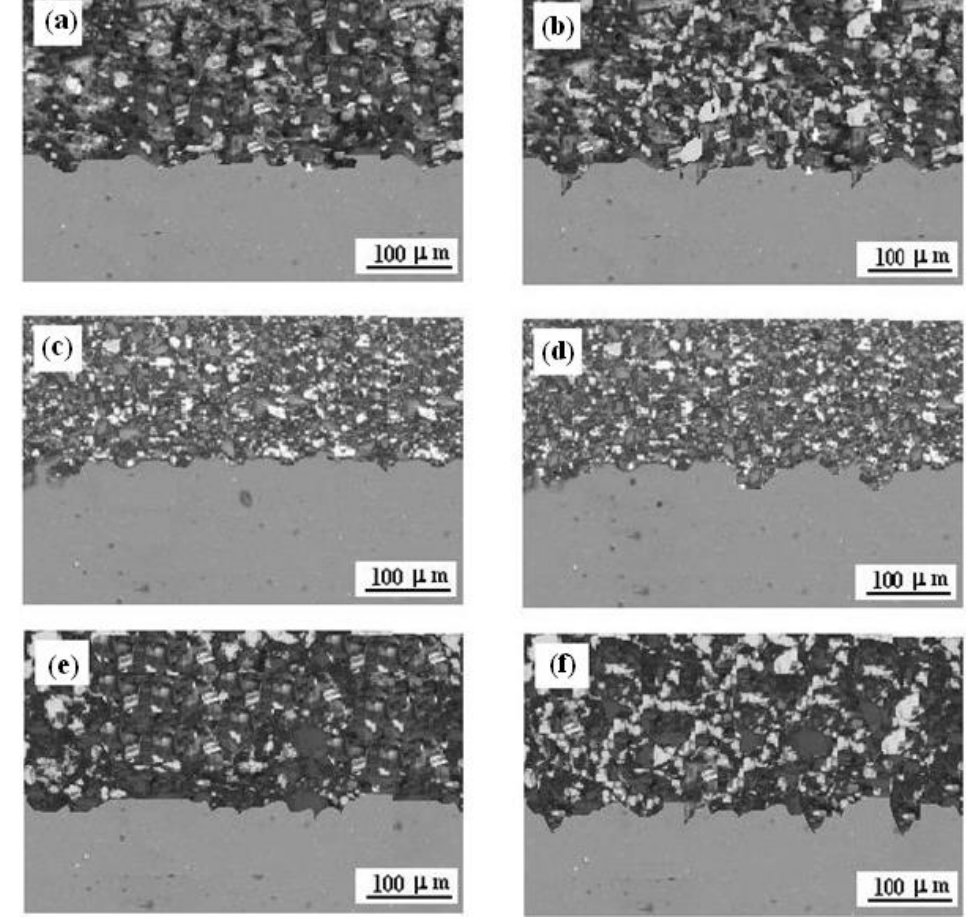
Figure 9. SEM of cross-section of titanium deposited onto Al7075 substrate at the SoD of: ( a ) 20 mm, ( b ) 70 mm, and ( c ) 100 mm, and after exposure at 1.2 M Cl - (pH 1.5) at SoD of: ( b ) 20 mm, ( d ) 70 mm, ( c ) 70 mm, and ( e ) 100 mm, and after exposure at 1.2 M Cl − (pH 1.5) at SoD of: ( b ) 20 mm, ( d ) 70 mm, and ( f ) 100 mm. Exposure time was 4 h. and ( f ) 100 mm. Exposure time was 4